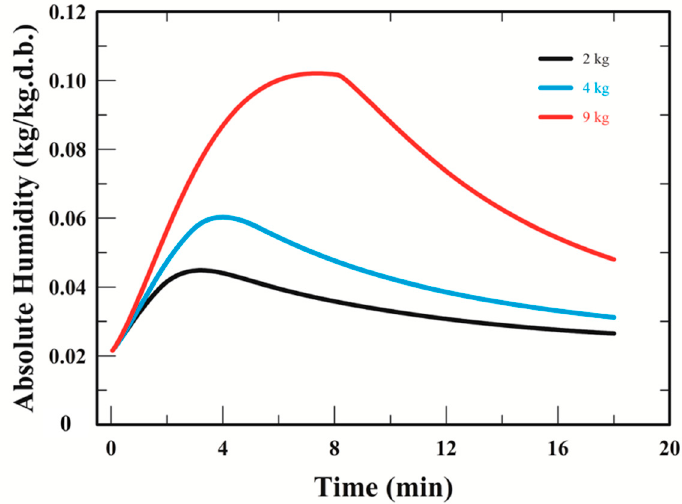
Figure 5. Simulated results of the change in humidity of the hot air in the fluidized bed dryer (FBD) during drying with different loadings, from 2 to 9 kg, at 120 °C.